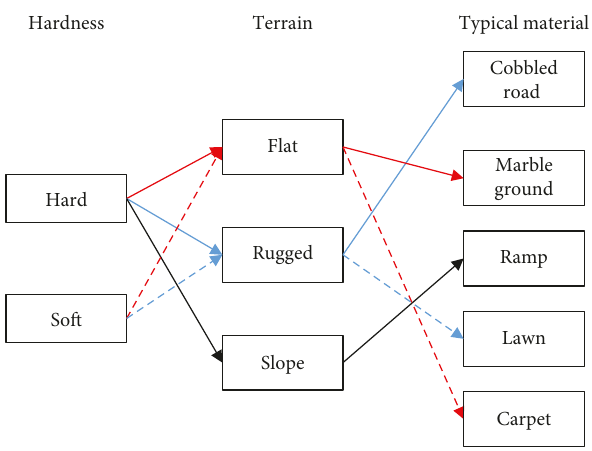
Figure 2: The common application environment for users of AIDER. The solid line and dotted line stand for hard and soft features, respectively; red, blue, and black denote fl at, rugged, and slope features,